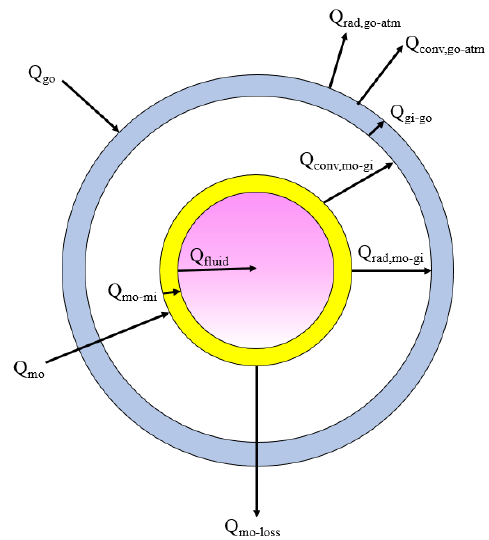
Figure 4. The energy balance for the solar receiver.